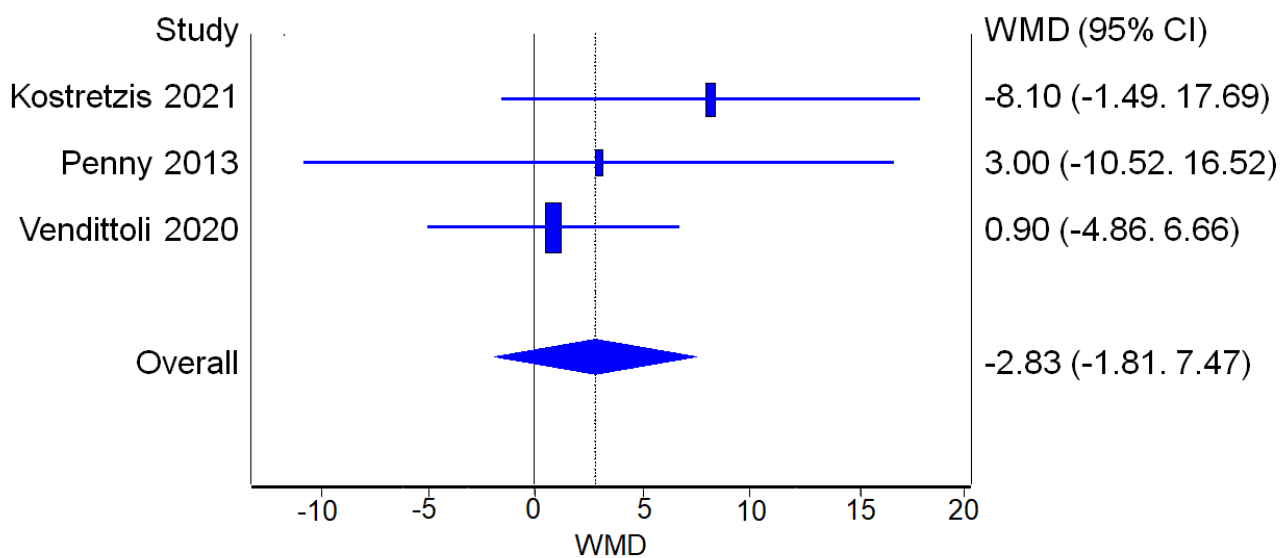
Figure 8. WOMAC: Forest plot of the individual studies and pooled mean difference for WOMAC improvement, including a 95% confidence interval. The size of the squares shows the weight of the study. [17 – 20,25,28 – 31].